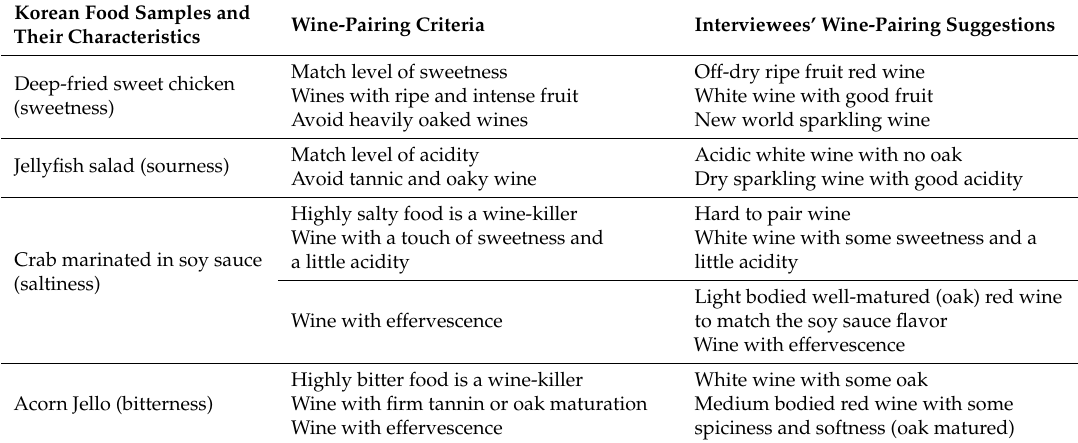
Table 2. Comparison between the pairing criteria and the interviewees’ wine suggestions for sweet, sour, salty, and bitter food samples.